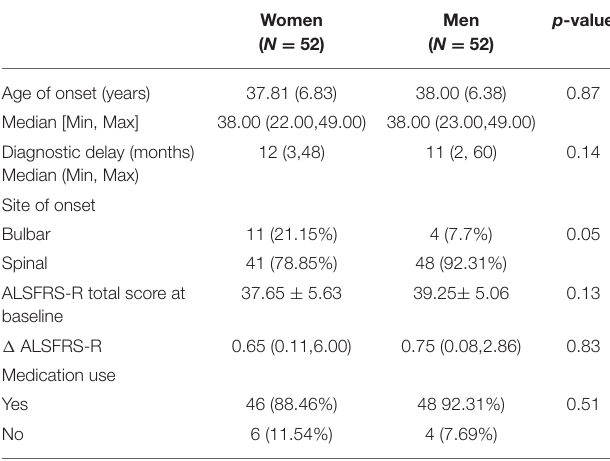
TABLE 1 | Clinical characteristics of male and female patients affected by ALS aged 15–49